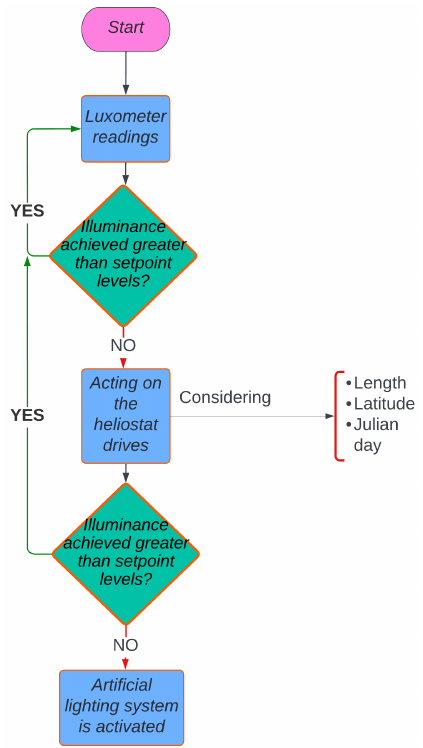
Figure 13. Diagram of the management and programming of the monitoring system.